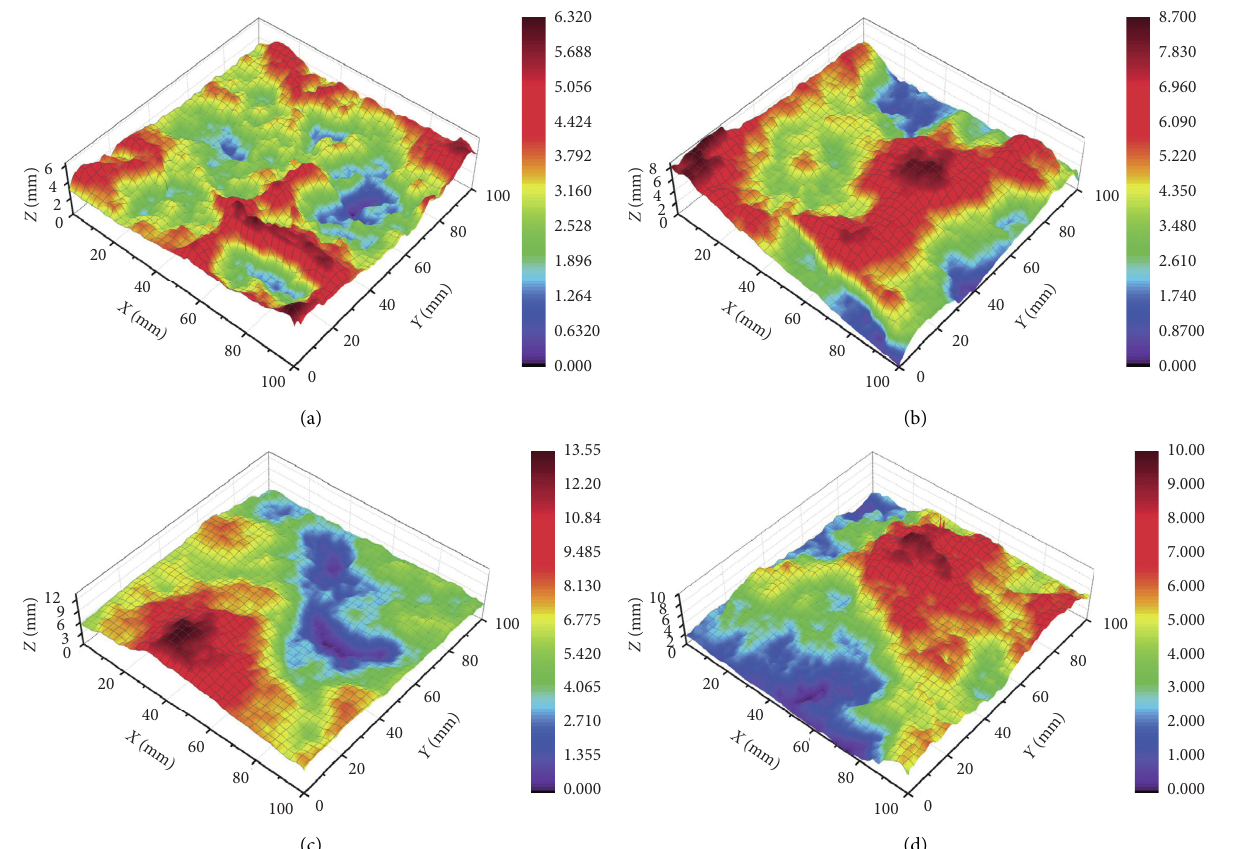
Figure 12: Schematic diagrams of 4 joint surface models. (a) Joint J-1. (b) Joint J-2. (c) Joint J-3. (d) Joint J-4.